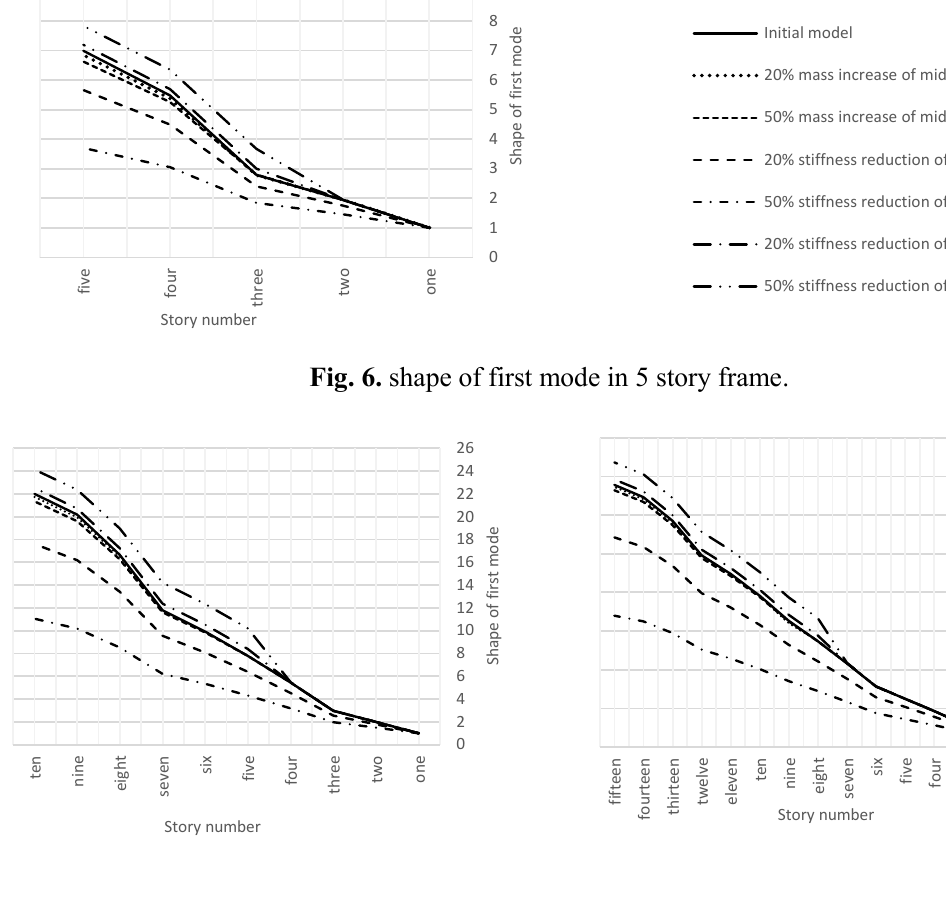
Fig. 7. shape of first mode in 10 story frame. Fig. 8. shape of first mode in 15 story